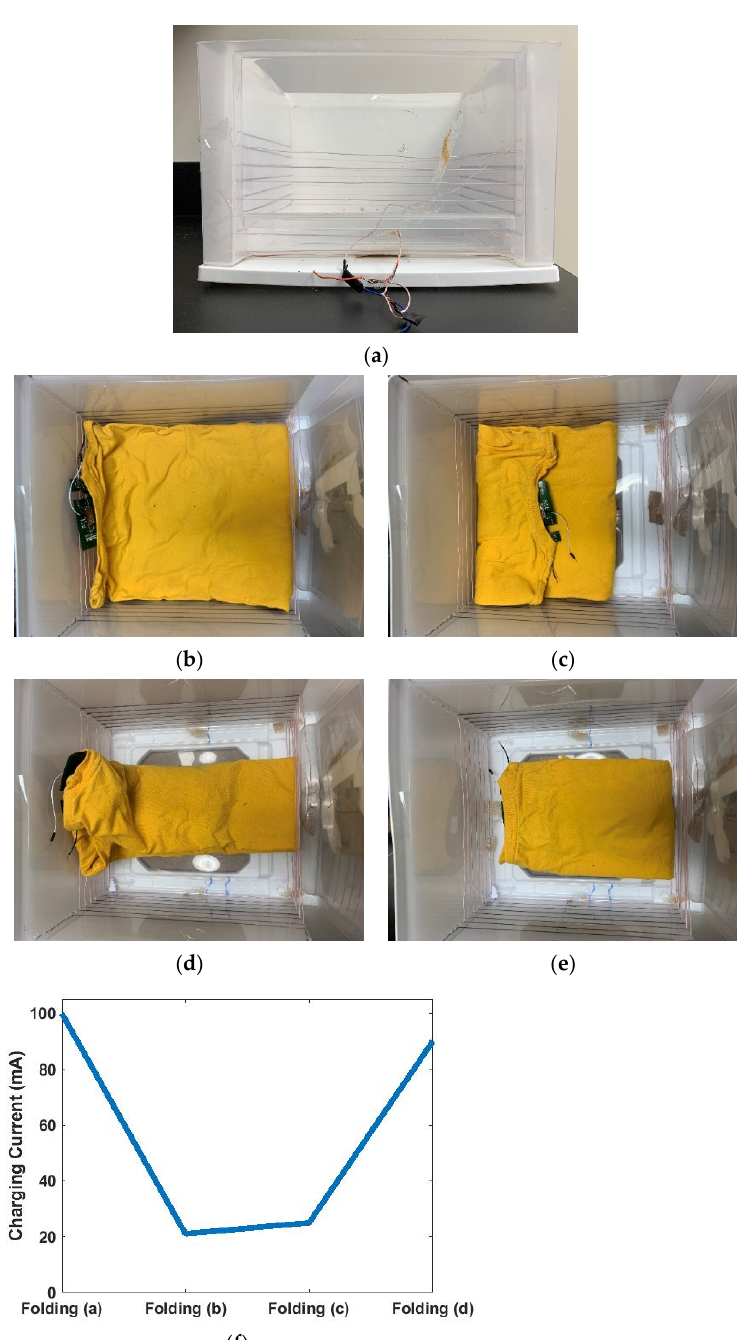
Figure 25. Measuring wireless-charging drawer system: ( a ) wireless charging drawer prototype; ( b ) no coil folded; ( c ) large coil folded and small coils close to drawer sidewall; ( d ) large coil folded and small coils in the center of drawer; ( e ) small coils folded and large coil in the center of drawer; ( f ) measured charging current under these four scenarios.